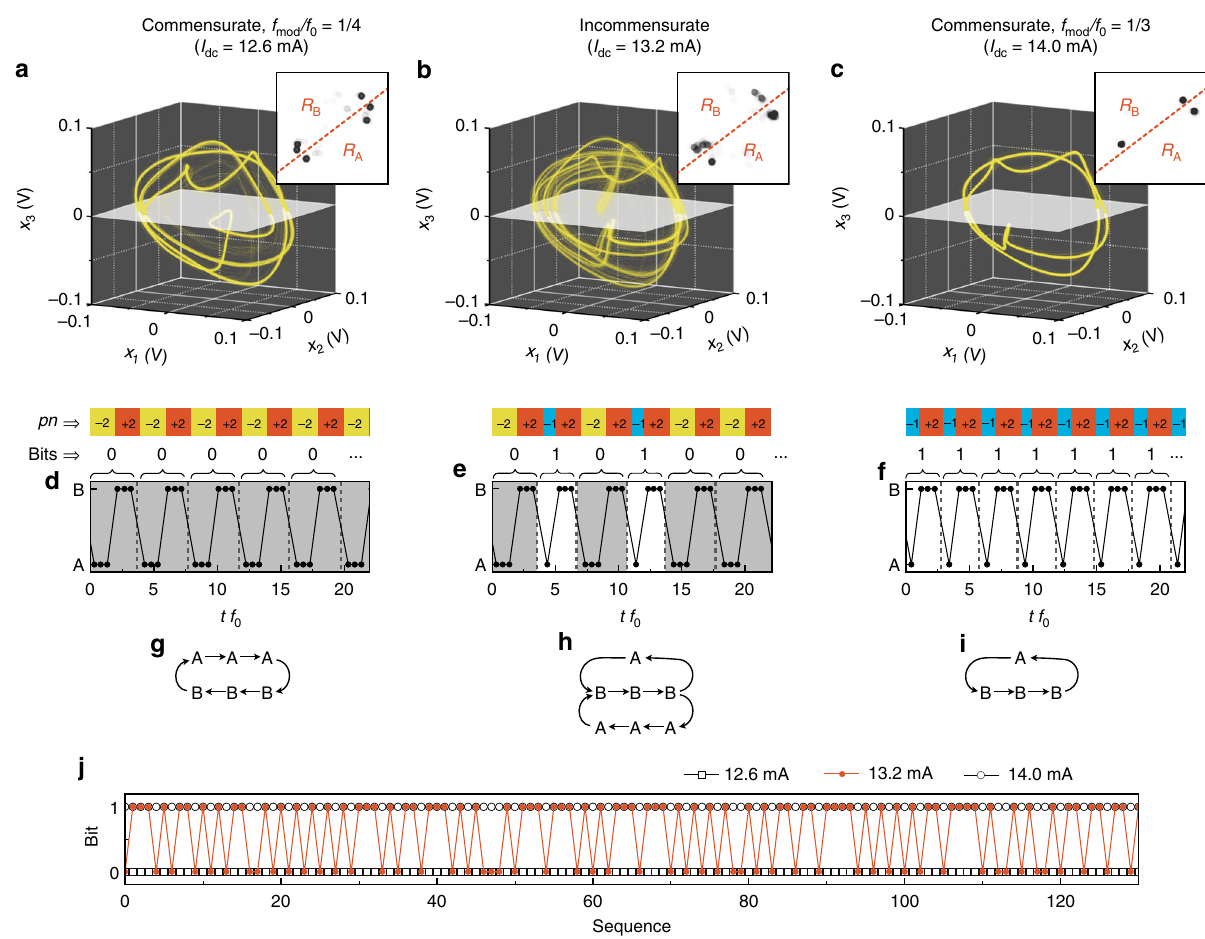
Fig. 3 Reconstructed attractor geometries and symbolic dynamics. a – c Reconstructed attractor geometries by a method of delay from the measured time = 12.6, 13.2, and 14.0 mA, respectively. The white plane is arbitrarily chosen Poincaré surface of section (see Methods). (Inset) Poincaré maps traces at I dc at the surfaces. The red dashed lines indicate a simple partition to divide the plane into two regions, R and R , for encoding symbols, A and B. The Poincaré A B surface of section and partitions are identical for all I in these fi gures. d – f Dynamics of symbols de fi ned from the partition on the Poincaré' maps. Above dc the graphs, corresponding pn patterns and generated bit sequences are represented. The bits are de fi ned as 0 (cid:5) [A,A,A,B,B,B] and 1 (cid:5) [A,B,B,B]. g – i Rules = 12.6, 13.2, and 14.0 mA. j Generated bit sequences for long term at I = 12.6, 13.2, and 14.0 of the symbolic dynamics at I dc dc